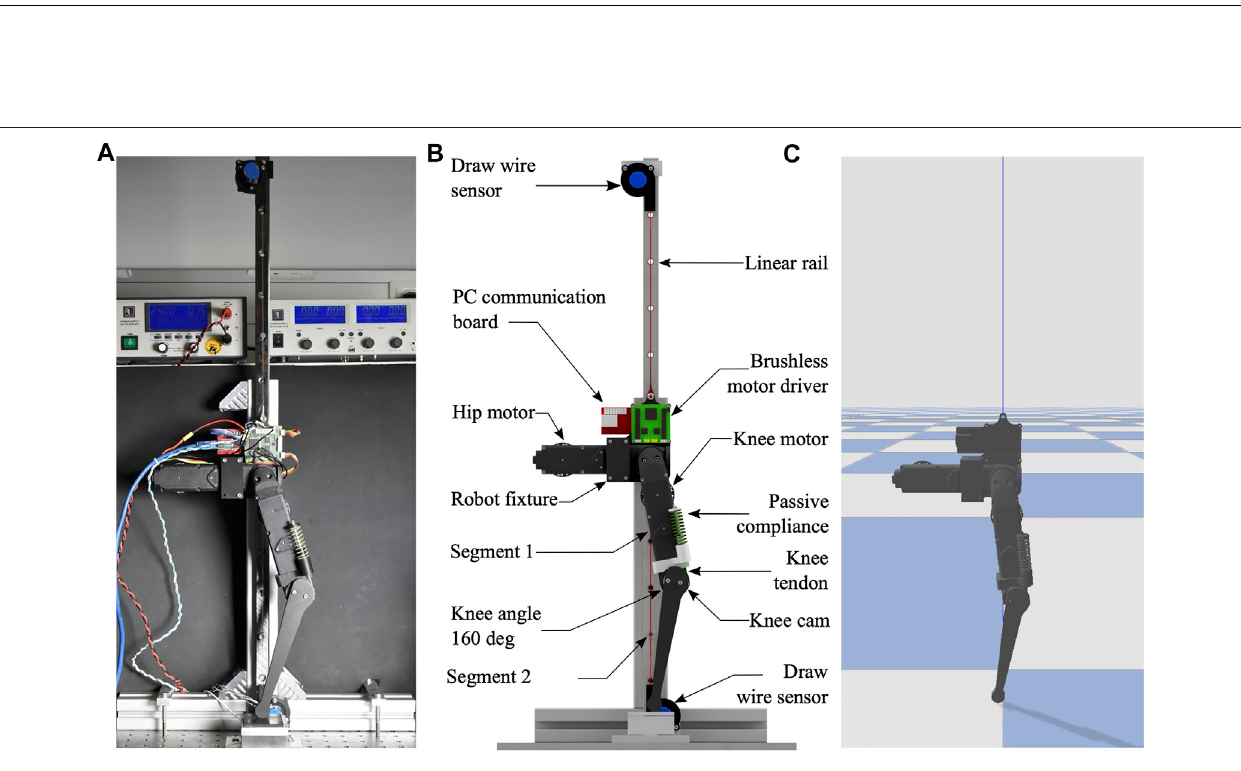
Frontiers in Robotics and AI |